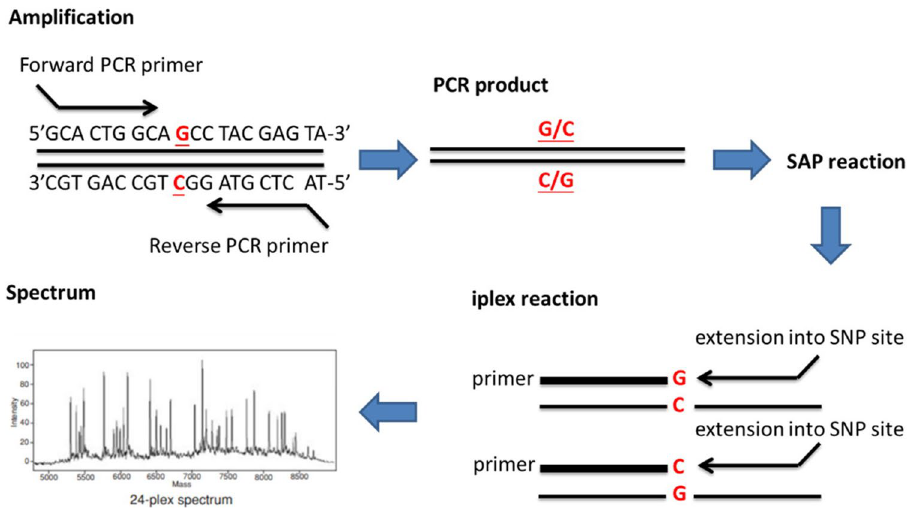
Figure 2. Experiment steps in genotyping using MassARRAY system. (a) Locus-specific amplification reaction. (b) Use SAP enzyme to unincorporated dNTPs. (c) Locus-specific primer extension reaction. The single base extension using mass-modified dideoxy-nucleotide terminators of an oligonucleotide primer. (d) Mass spectrum. By measuring the time-of-flight, the software will automatically analyze the mass of the analytes into a